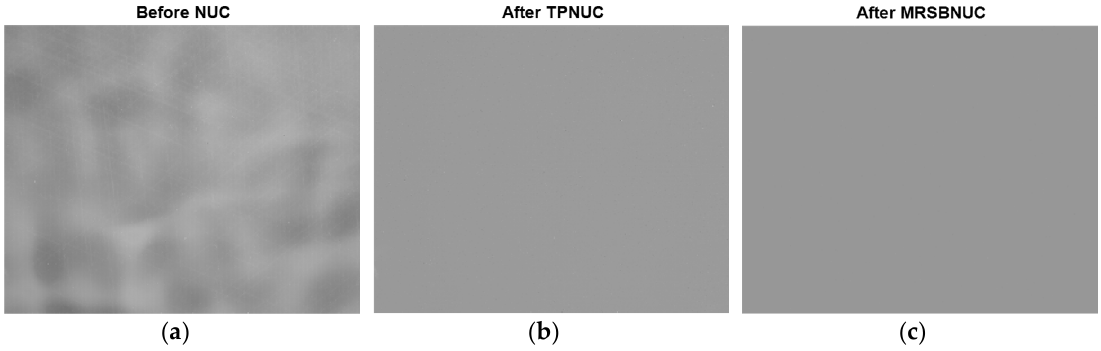
Figure 10. Clear sky scenes: ( a ) before NUC, ( b ) after TPNUC and ( c ) after MRSBNUC.